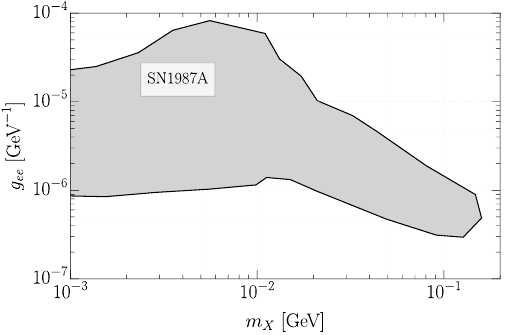
Figure 3 . Constraint on g ee with respect to m X , derived in ref. [89] from the supernova cooling